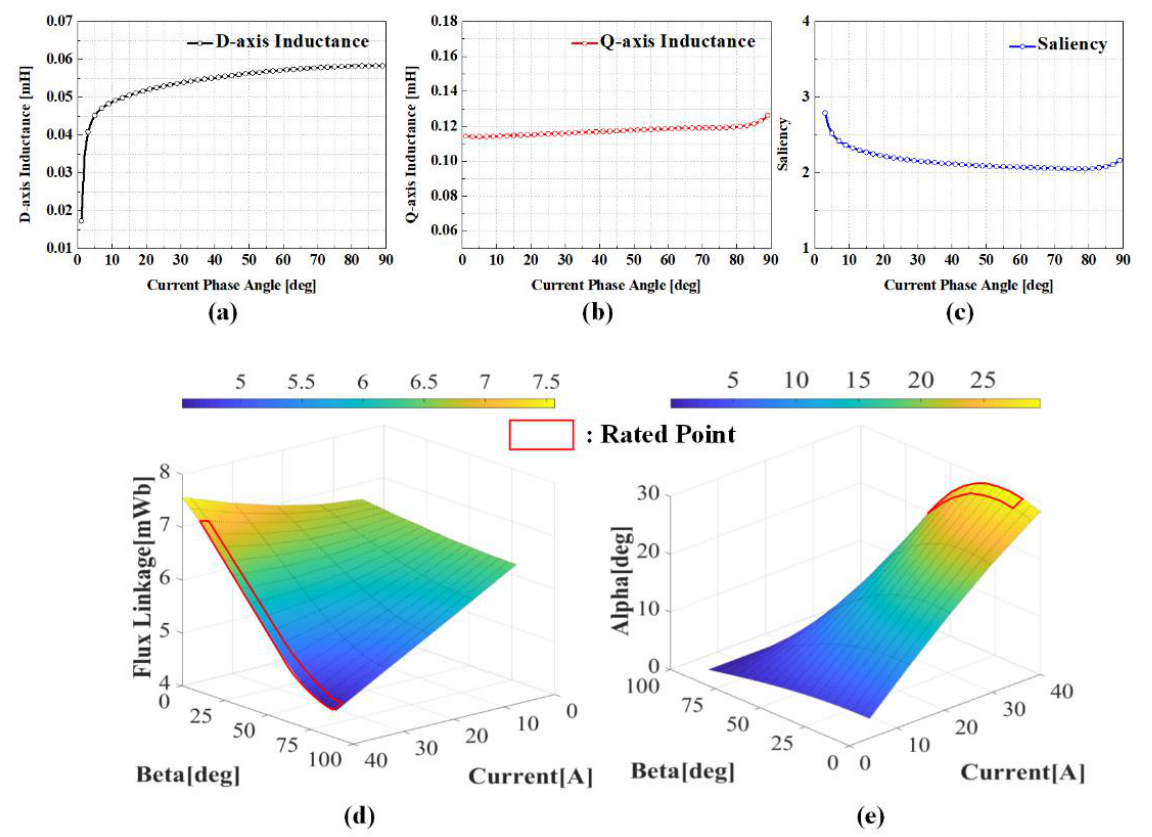
Figure 4. Calculation of d-, q-axis inductance, flux linkage, and phase difference at no-, on-load flux linkages according to input current and current angle. ( a ) d-axis inductance, ( b ) q-axis inductance, ( c ) saliency, ( d ) flux linkage, and ( e ) flux linkage phase difference angle.